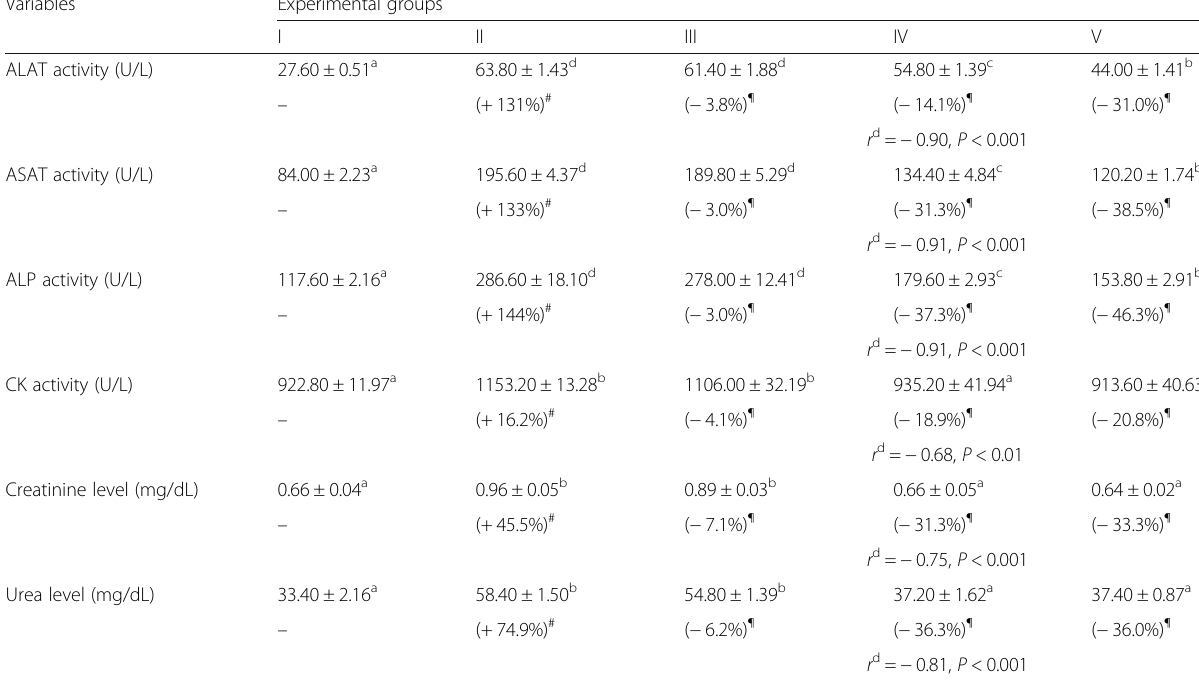
Table 6 The activities of alanine and aspartate aminotransferases (ASAT and ALAT), alkaline phosphatase (ALP), and creatine kinase (CK) as well as levels of creatinine and urea in the serum of all the experimental groups, at the end of the experiments Variables